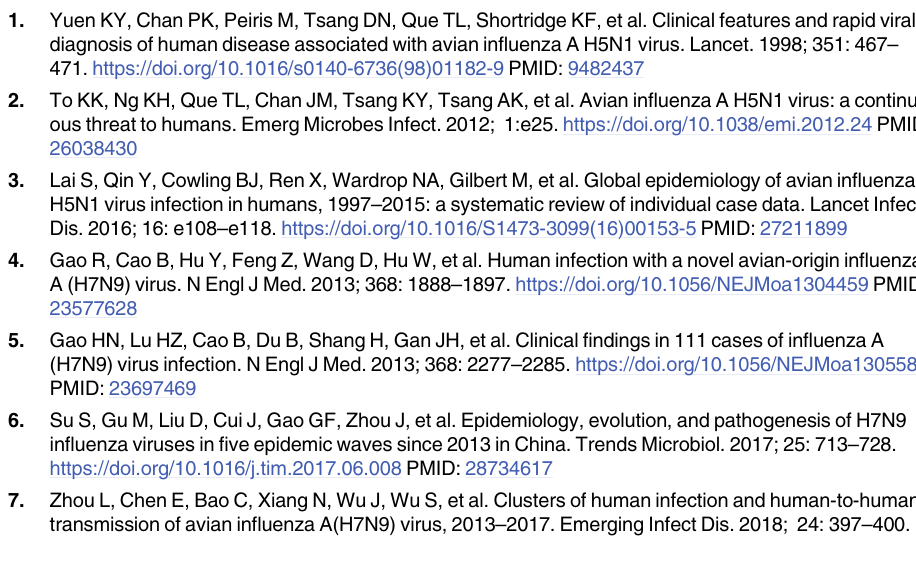
Fig 3K. ( J ) Flag-MAVS was expressed as in Fig 3L. (TIF) S4 Fig. pCAGEN-MAVS had stronger expression level than pEF-Bos-MAVS. HEK293T cells in 24-well plates were transfected with 50 ng pCAGEN-myc-MAVS or pEF-Bos-Flag- MAVS plus 100 ng p125-Luc and 10 ng pRL-TK. After 48 hours, cells were harvested for dual- luciferase reporter assay.